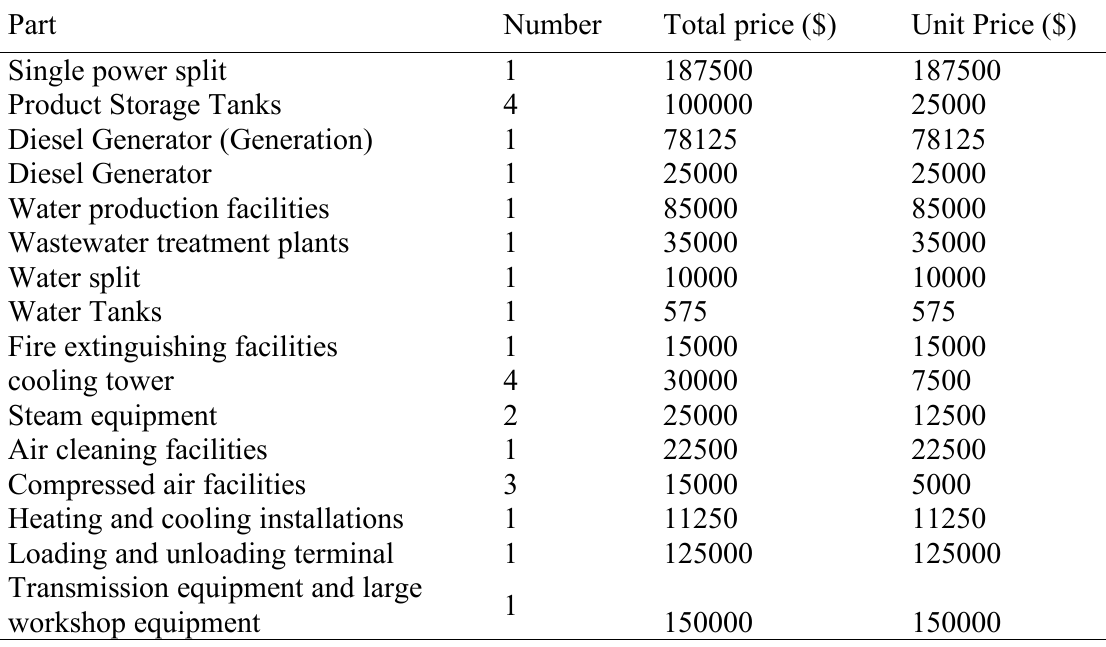
Table 6. Total cost of equipment on the side of